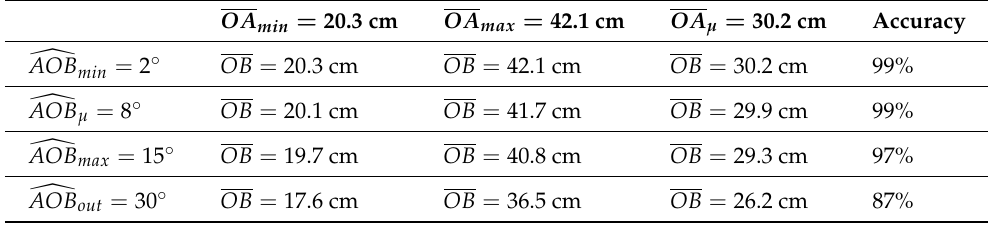
Table 6. The vertical heights OB calculated for each combination of the min/max/avg distances OA (cid:91) AOB and angles